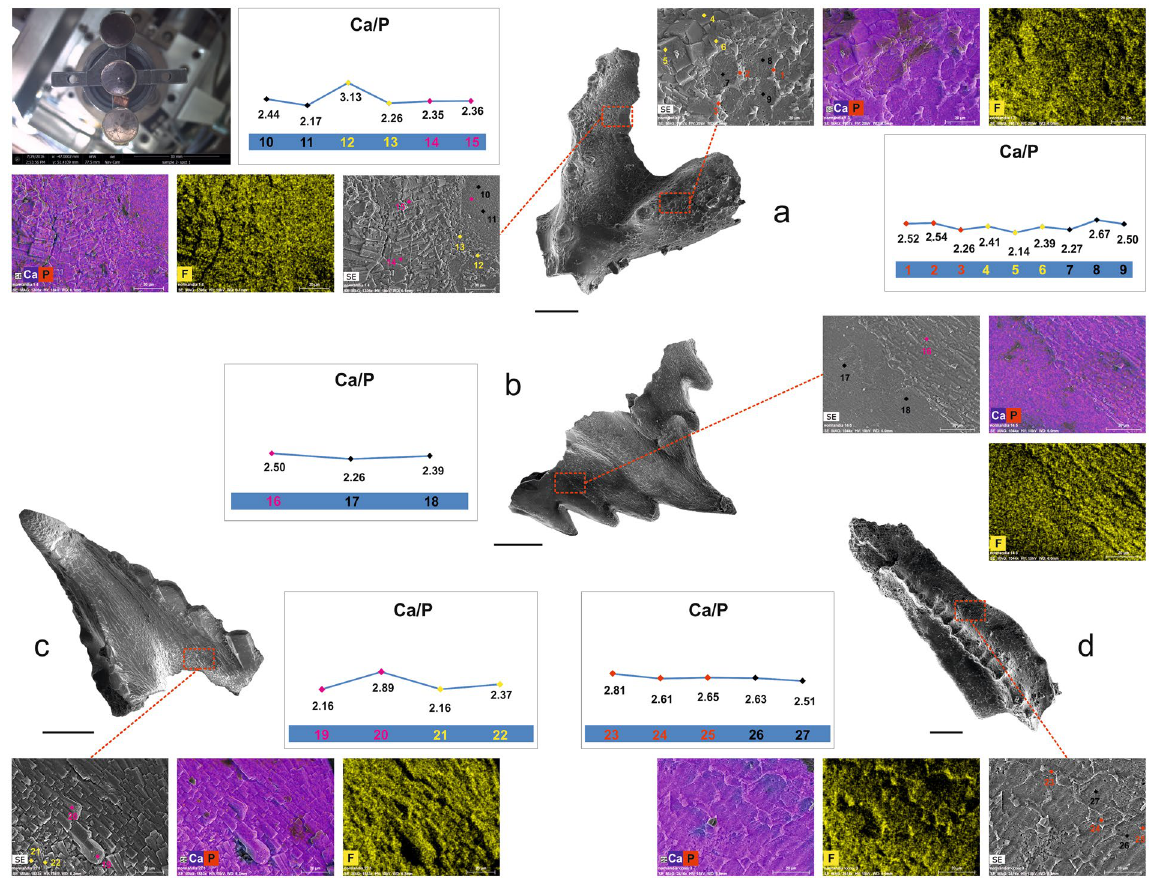
Figure 3. Chemical composition. ESEM image, SEM-EDS elemental maps (Ca + P and F) and Ca/P ratio. ( a ) Sagittodontina robusta , Pa element; specimen IPUM 28991, sample W1-2006. 1-3: web-like crystal microtexture (red spots); 4–6: blocky crystal microtexture (yellow spots); 7–9: smooth parts of the element (black spots); 10–11: smooth surface (black spots); 12–13: blocky crystal microtexture (yellow spots); 14–15: large columnar crystal microtexture (purple spots). ( b ) Sagittodontina robusta , Pa element; specimen IPUM 28770, sample W-BK(C)-2006. 16: large columnar crystal microtexture (purple spot); 17–18: smooth element (black spots). The marked contact between the crystalline and the smooth part of the element is notable. ( c ) Icriodella superba , Sa element; specimen IPUM 28761, sample W-BK(B)-2006. 19–20: large columnar crystal microtexture (purple spots); 21–22: blocky crystal microtexture (yellow spots). ( d ) Amorphognathus sp., Pa element; specimen IPUM 28990, sample W1-2006. 23–25: web-like crystal microtexture (red spots); 26-27: smooth surface (black spots). Scale bars correspond to 100 μ